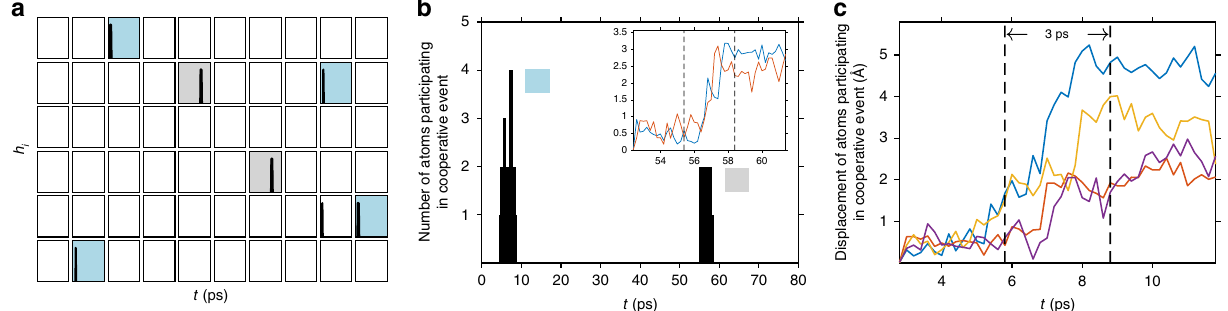
Fig. 3 Detection of Li-ion migration events. a Identi fi cation of speci fi c Li ions that migrate at 300 K. Each rectangle individually plots h i (Eq. 3) vs. simulation time for the 60 Li ions in the simulation cell. b Number of atoms participating in a cooperative migration event, and the time at which those events were observed. Blue and gray shading in panels ( a ), ( b ) identify, respectively, the Li ions that migrate during the fi rst and second cooperative events shown in panel ( b ). c Displacements of cooperatively migrating Li ions participating in the fi rst cooperative event (identi fi ed with blue shading in ( a )). The inset in ( b ) shows the displacement of Li ions participating in the second cooperative event (gray shading in panels ( a ), (